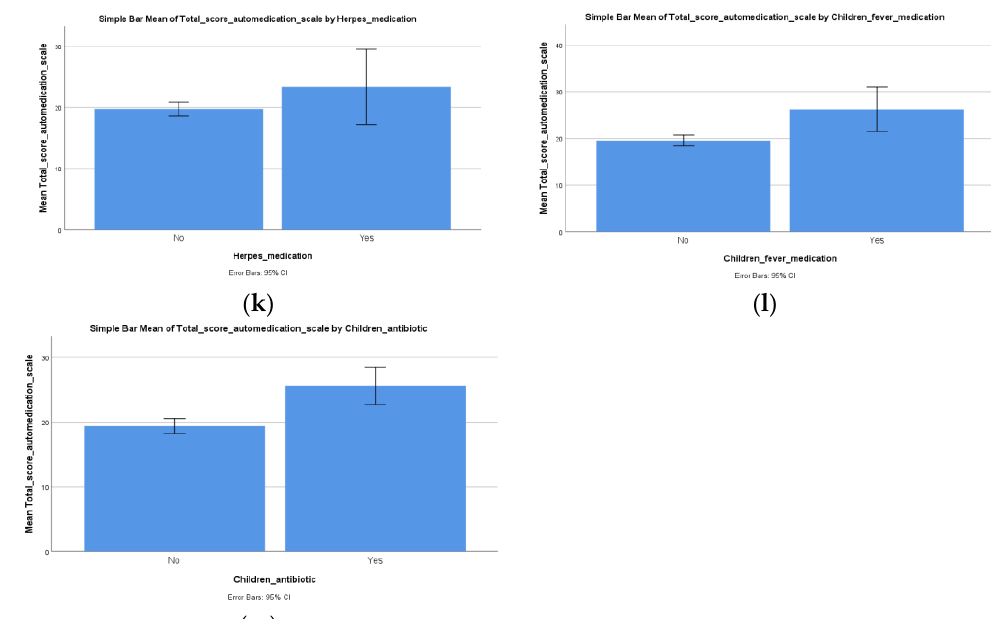
Figure 2. Self-medication aspects: Differences regarding the total score on self-medication scale between the two ( a ) ampicillin-use groups, ( b ) Augmentin-use groups, ( c ) clarithromycin-use groups, ( d ) Biseptol-use groups, ( e ) codeine-use groups, ( f ) Algocalmin-use groups, ( g ) paracetamol-use groups, ( h ) cough-syrup-use groups, ( i ) omeprazole-use groups, ( j ) eye-drop-use groups, ( k ) herpes-medication-use groups, ( l ) fever medication for children use groups, and ( m ) antibiotics for children use groups.